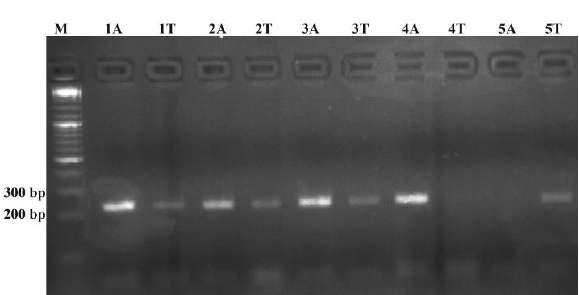
Figure 2. Agarose Gel Result of the Polymerase Chain